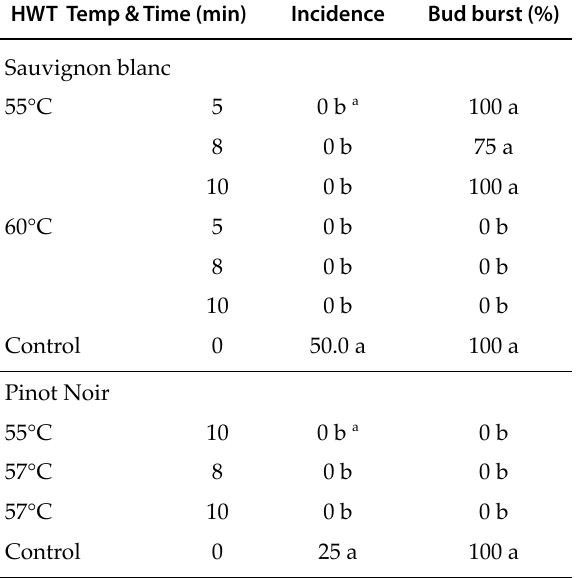
Table 4. Mean pathogen incidence in Sauvignon blanc and Pinot noir canes treated with different temperatures and times of hot-water treatments being superficially inocu- lated with Neofusicoccum luteum conidia and percent bud- burst of treated canes after 4 weeks in growth conditions